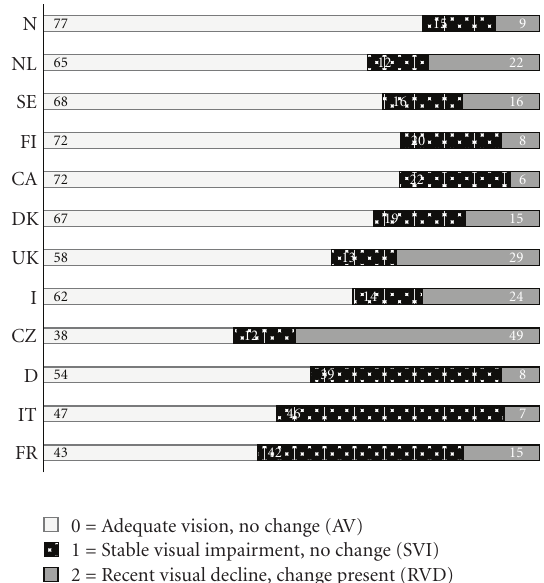
Figure 2: Self-reported visual impairment, stable and changed, through last 90 days in older people receiving homecare in 12 di ff erent country sites (%). N = 106328.